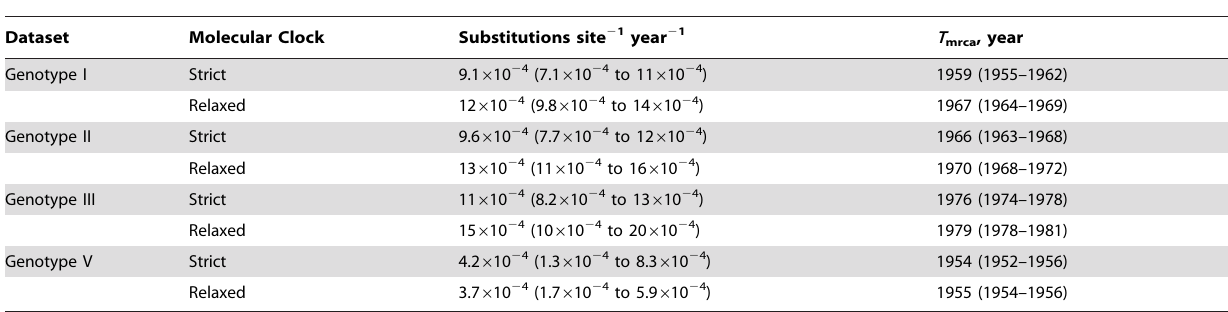
Table 2. Estimated substitutions rates and dates for DENV-3